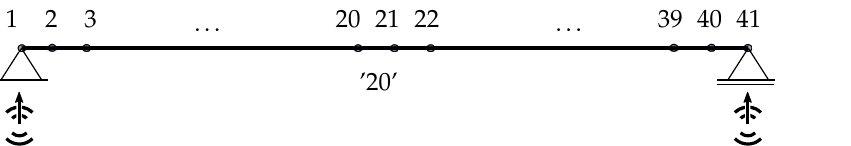
Figure 4. Sketch of the finite element model of the beam where some node numbers are indicatively shown, as well as the 20th element where damage is to be